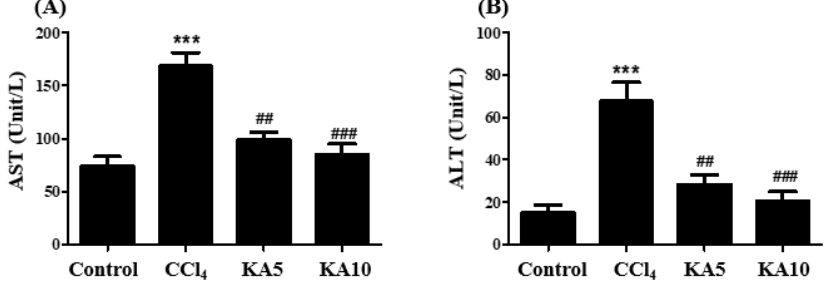
Figure 3. Effect of kaempferol on CCl 4 -induced serum parameter alterations. ( A ) Aspartate transaminase (AST); ( B ) Alanine transaminase (ALT). Groups are as described in “Materials and Methods”. Values are mean ± SE ( n = 6). *** p < 0.001 vs. the control group, ## p < 0.01, and ### p < 0.001 vs. the CCl 4